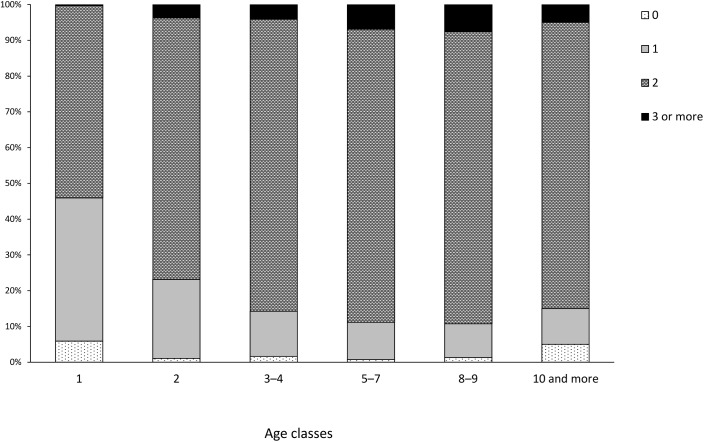
Relative frequencies of the number of CL in roe deer females of different age classes in Slovenia in the period 2013–2015 (n = 1312).Note that age was estimated using macroscopic inspection of tooth-wear, a method that is less accurate (especially) in older animals.